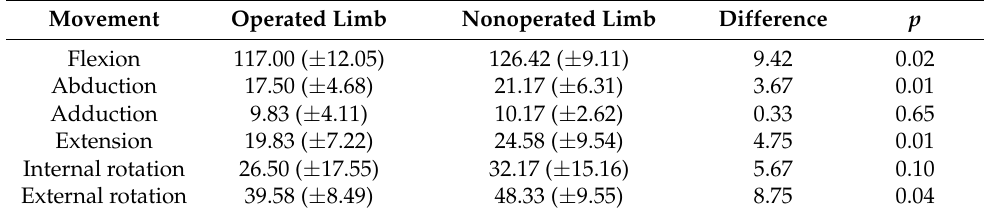
Table 1. Range of motion in both limbs in degrees ( ◦ ).